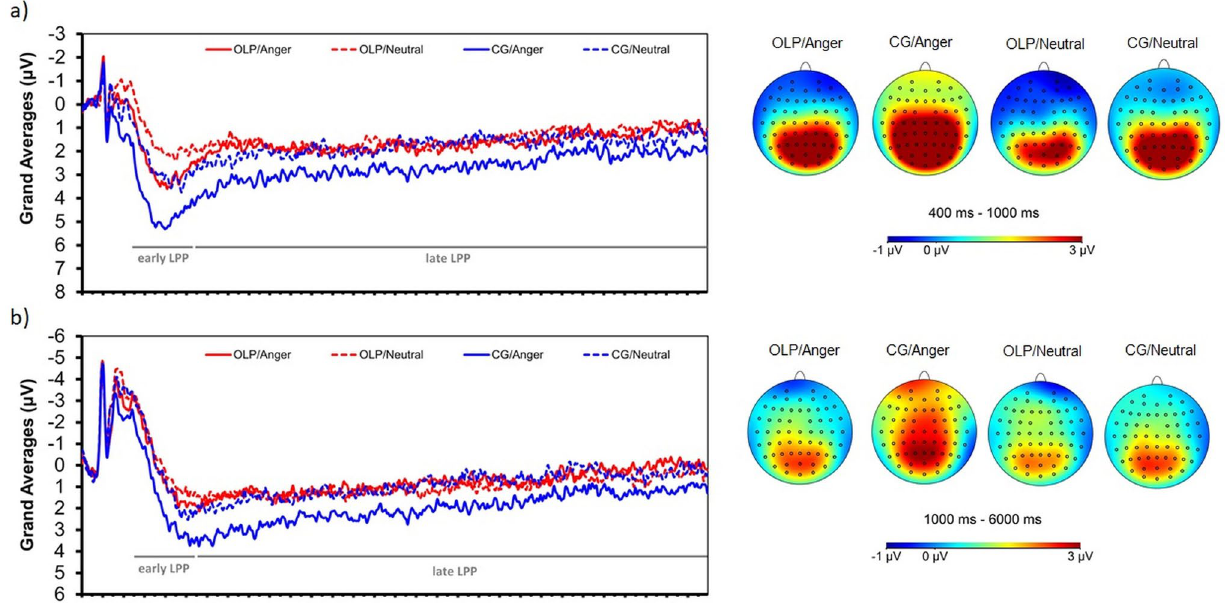
Figure 2. Grand averages (and headmaps) for angry and neutral faces in the open-label placebo group (OLP) and the control group (CG) across the centroparietal cluster ( a ) and the frontal cluster ( b